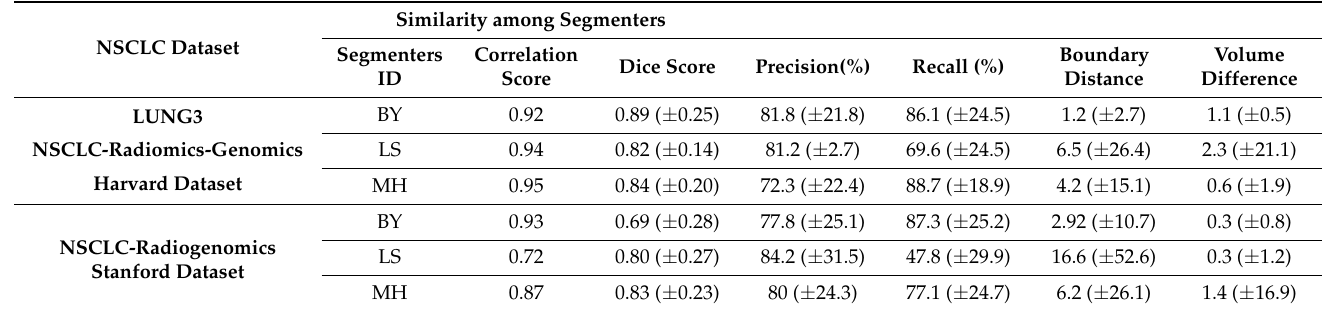
Table 3. Similarity of the radiomic signatures using multiple scoring methods among different segmenters are presented.